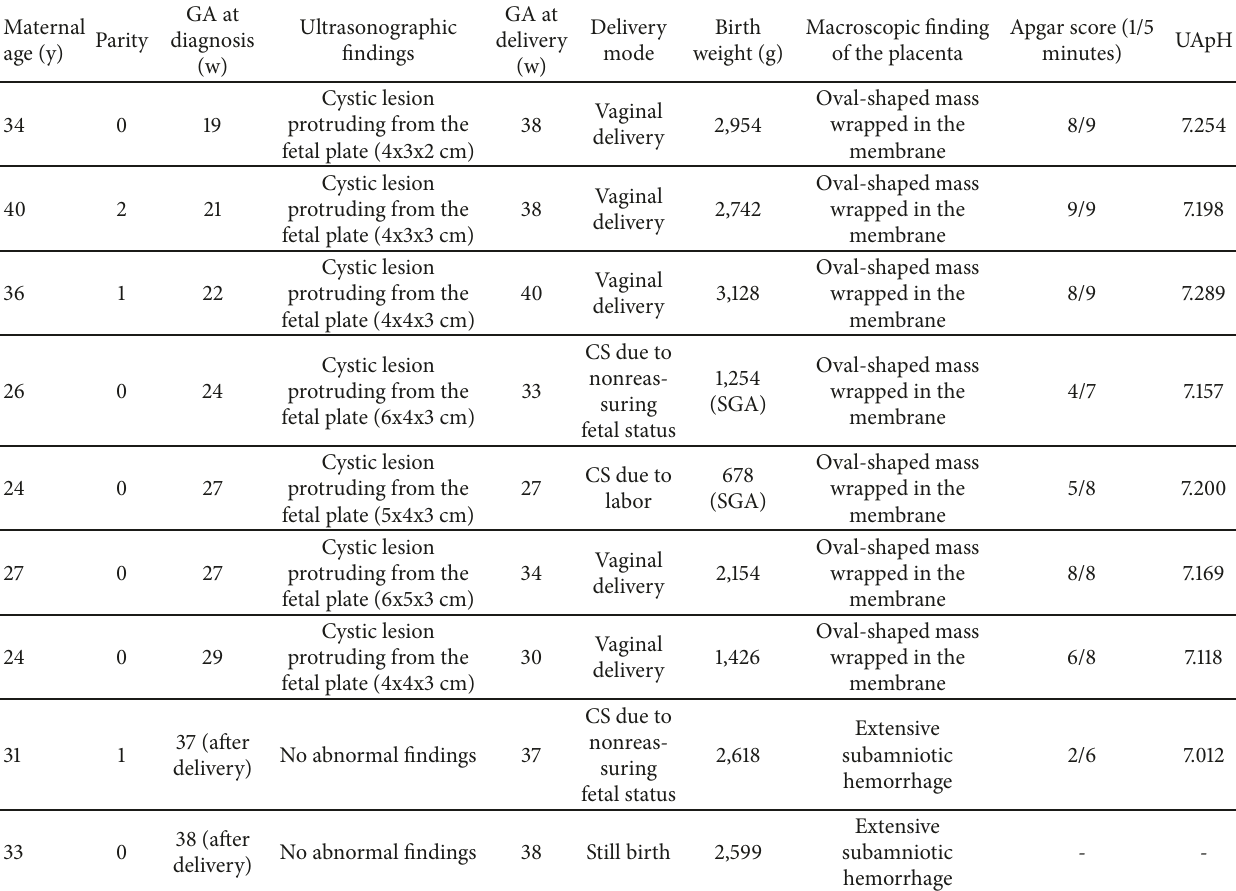
Table 1: Cases of subamniotic hemorrhage managed at our